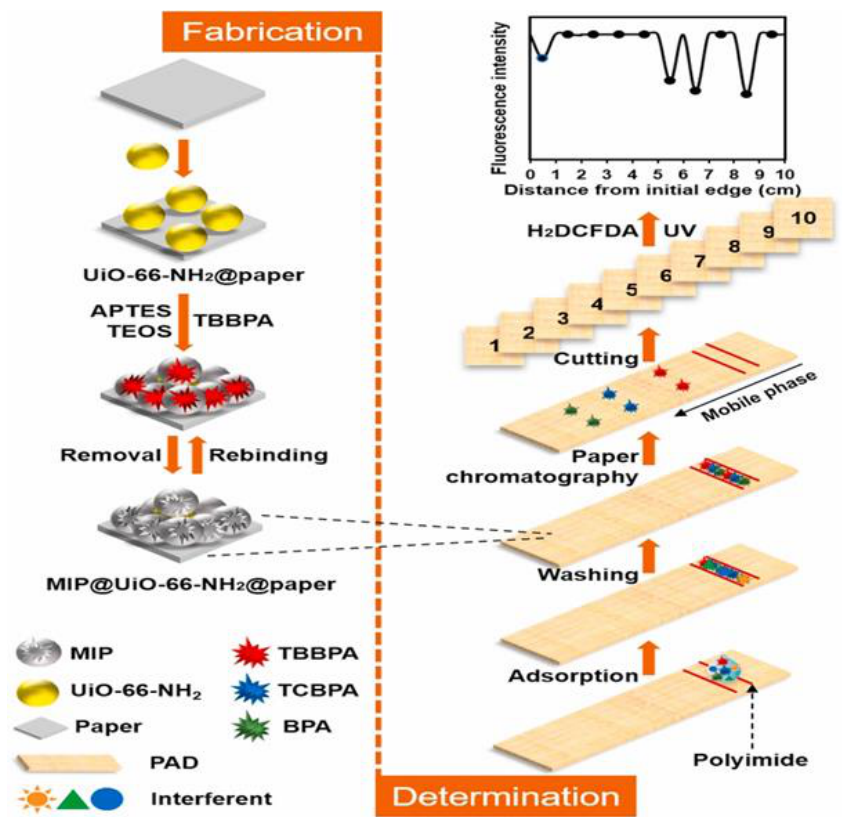
Figure 7. Schematic of the preparation of MIP@UiO-66-NH 2 @paper and associated analysis proce- dures. Reproduced with permission from Ref. [89]. Copyright 2021, Elsevier.